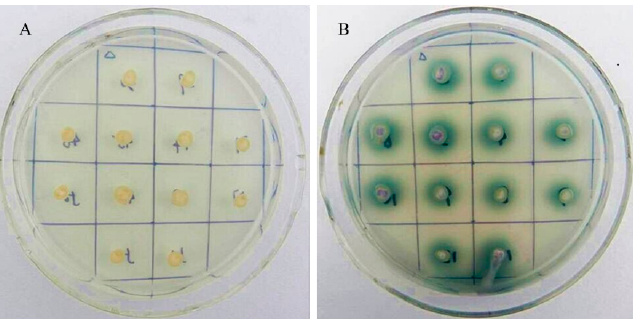
Figure 6. Screening of positive transformants with BMM medium. ( A ) pPIC9K acting as negative control ; ( B ) pPIC9K - Vvlcc3 .